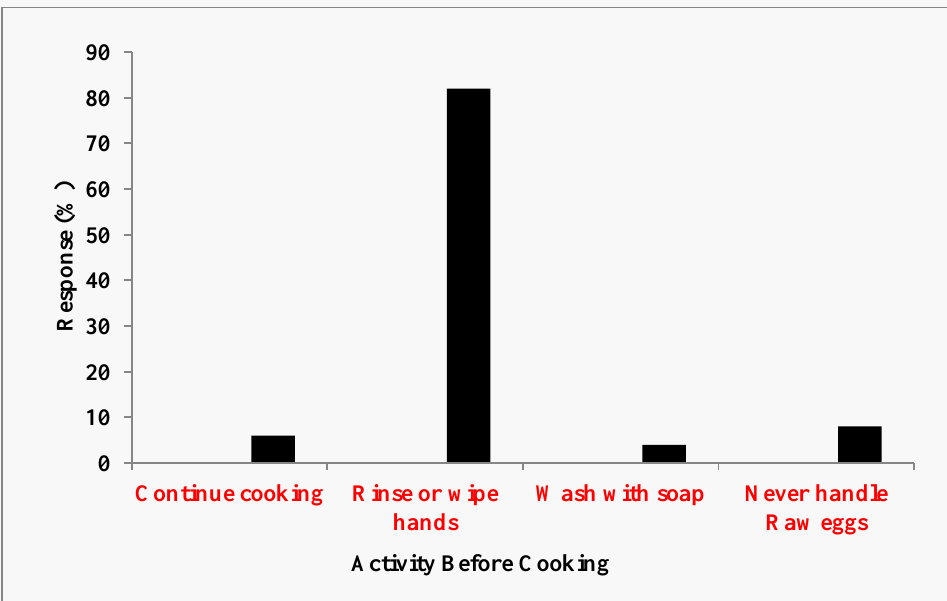
Figure 2. Sanitation activity after cracking raw